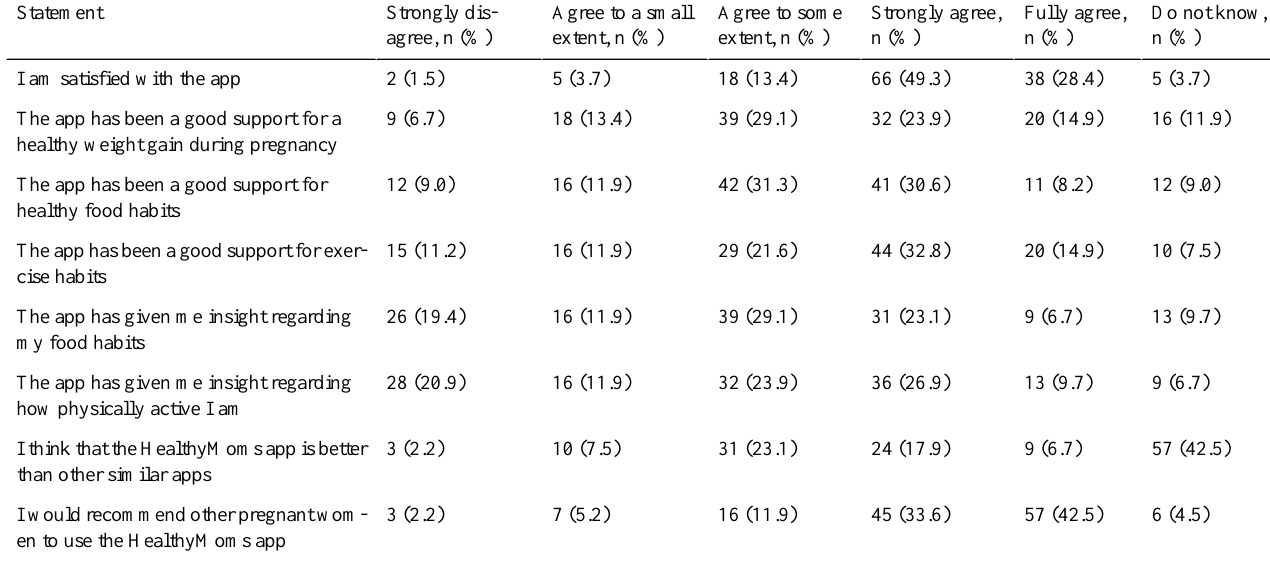
Table 2. Self-reported app satisfaction in the intervention group (n=134) at the follow-up measurement. Participants responded to the following statements with the 6 alternatives shown.